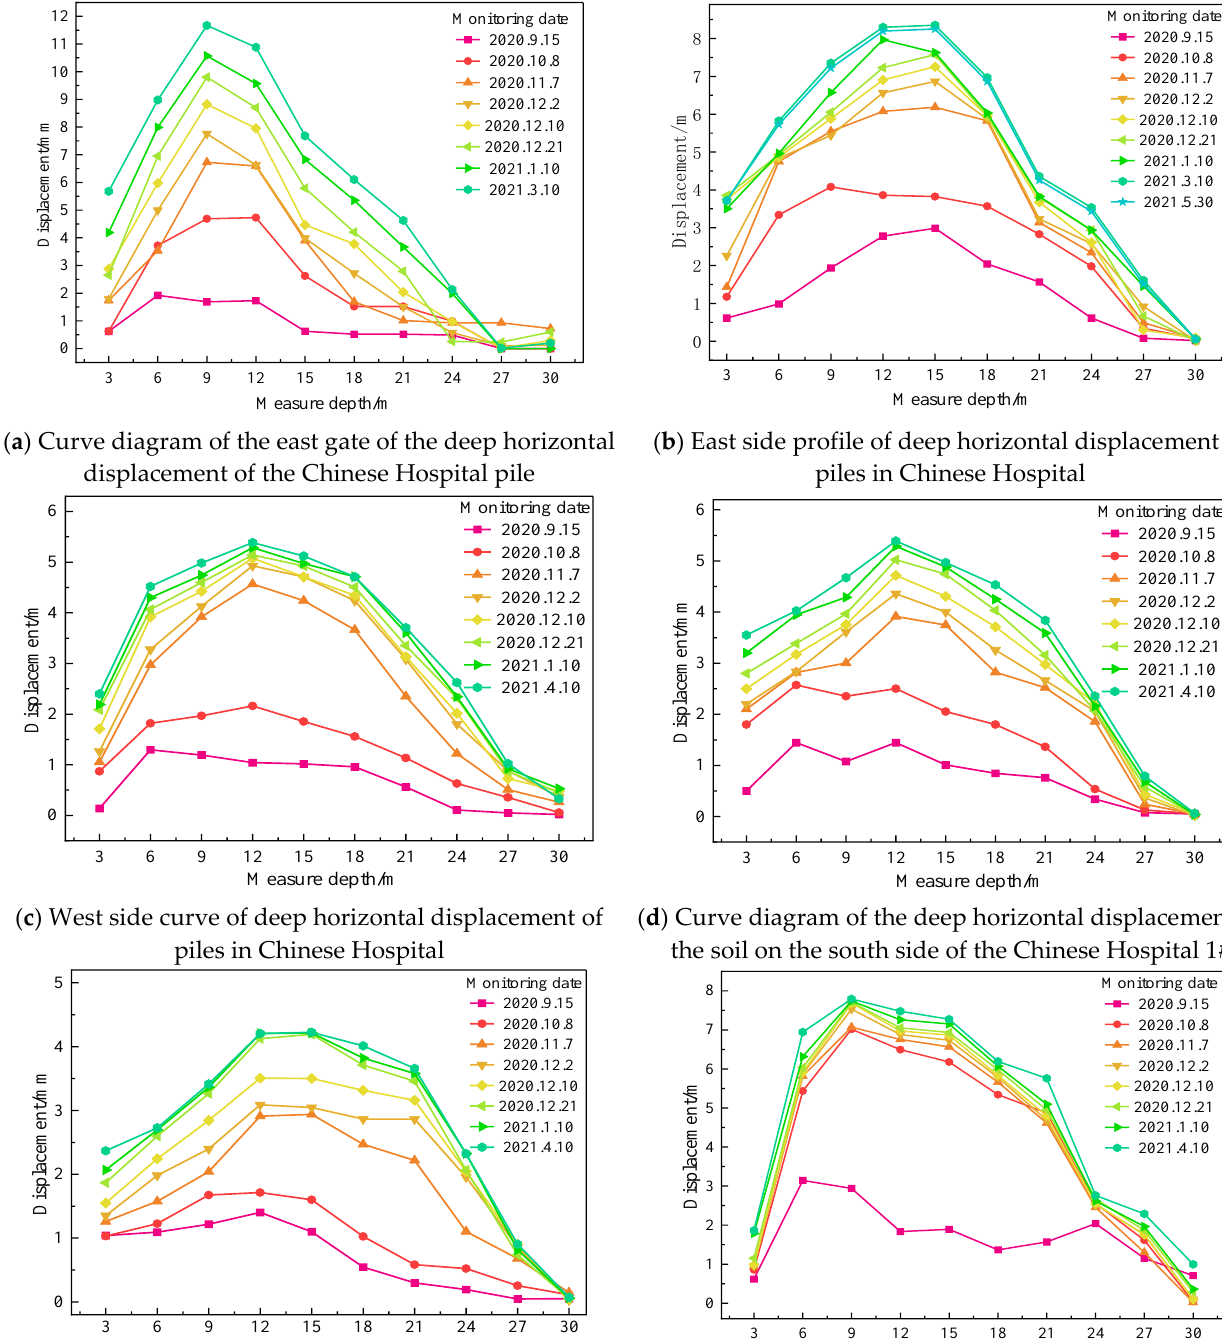
( e ) Deep horizontal displacement of the soil of the Chinese ( f ) Deep horizontal displacement of the soil of the Chinese Hospital 3# curve on the south side Figure 16. Deep horizontal displacement plot. Figure 16. Deep horizontal displacement According to the automatic early warning system of the monitoring system, it was found that on 17 December 2020, the water pipeline of the pump room on the west side of the site foundation pit ruptured, resulting in a change in the horizontal displacement data at this location (Figures 17 and 18). Through the timely warning of the monitoring system,